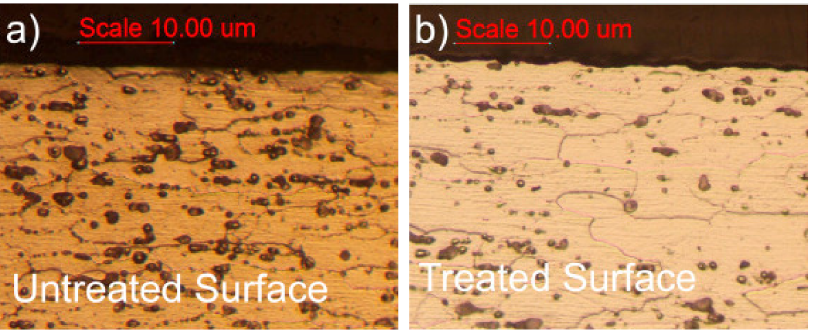
Figure 6. Schematic diagram of micrographs (“Scale 10.00 µ m” represents scale length of the mi- crograph of sections). ( a ) treated sample. ( b ) untreated sample. (Reprinted with permission from ref. [103]. Copyright 2016 Elsevier).